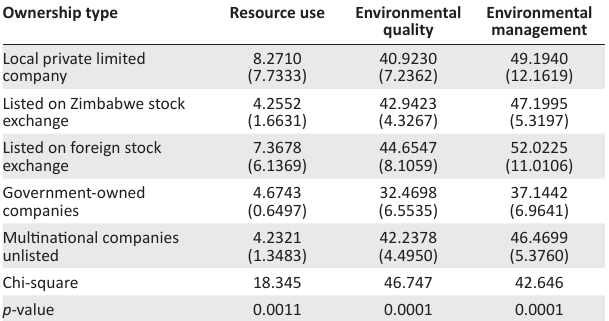
TABLE 5: The overall stewardship of the environment by the mining